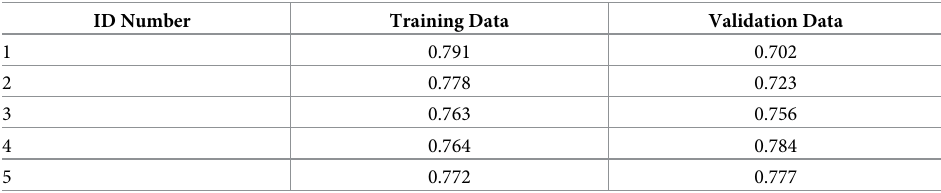
CAD, other-comorbidities, antiplatelet use, and aspirin. The gender variable was indepen- dently added to the model. We conducted a five-fold cross-validation to evaluate the perfor- mance of the model. We used the ROC curve and the AUC to report the predictive capability of the model. The results indicate that the model is very stable, and the average AUC or ’c’ sta- tistic of the validation is 0.749 (0.035). Table 4 indicates the AUC estimates of 5 training and validation datasets. Due to the penalized likelihood estimation method, the corresponding odds ratios will be biased and not reported in the manuscript. The model calculates the Table 4. The AUC estimates for 5-fold